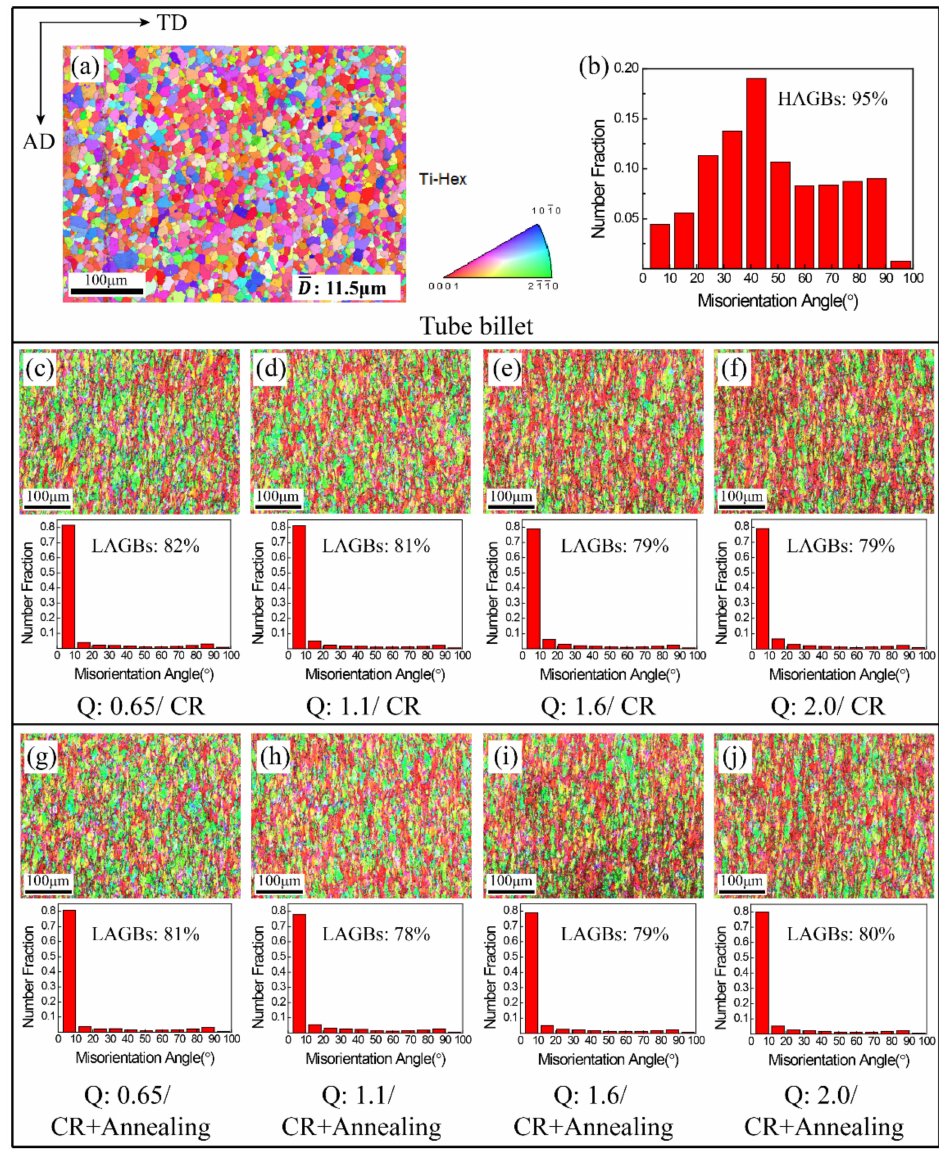
Figure 2. Orientation image and misorientation distribution of grain boundary of tubes. ( a ) Orienta- tion image of tube billet; ( b ) misorientation distribution of grain boundary of tube billet; ( c – f ) cold rolled tubes; ( g – j ) annealed